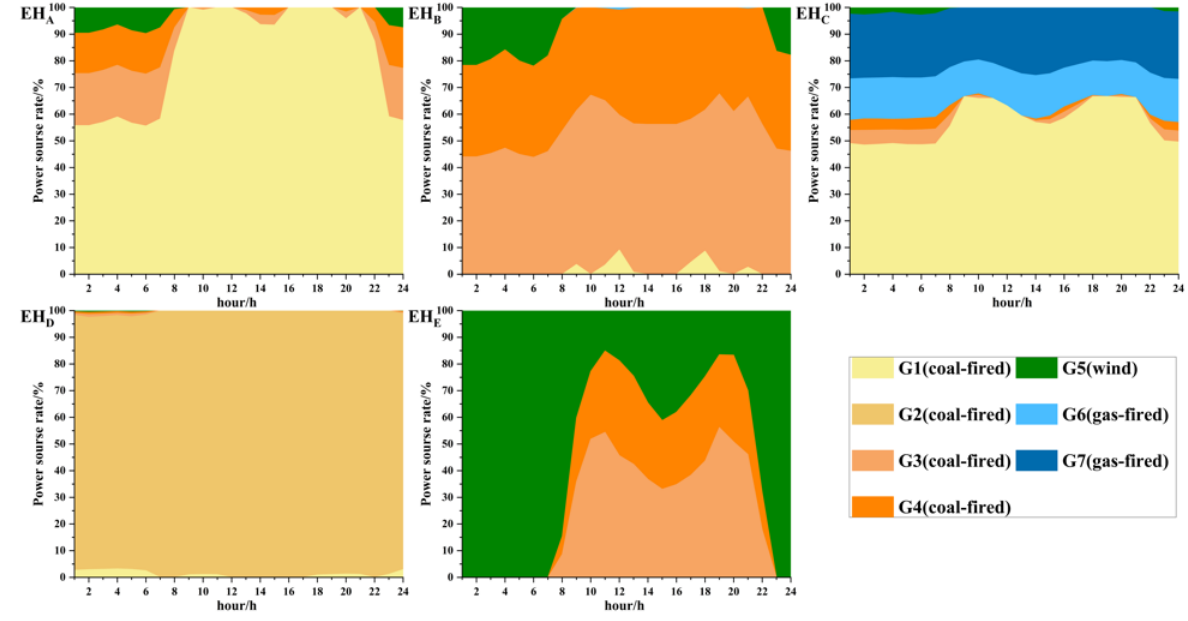
Figure 17. The power composition analysis diagram of each power load in Scenario 2.